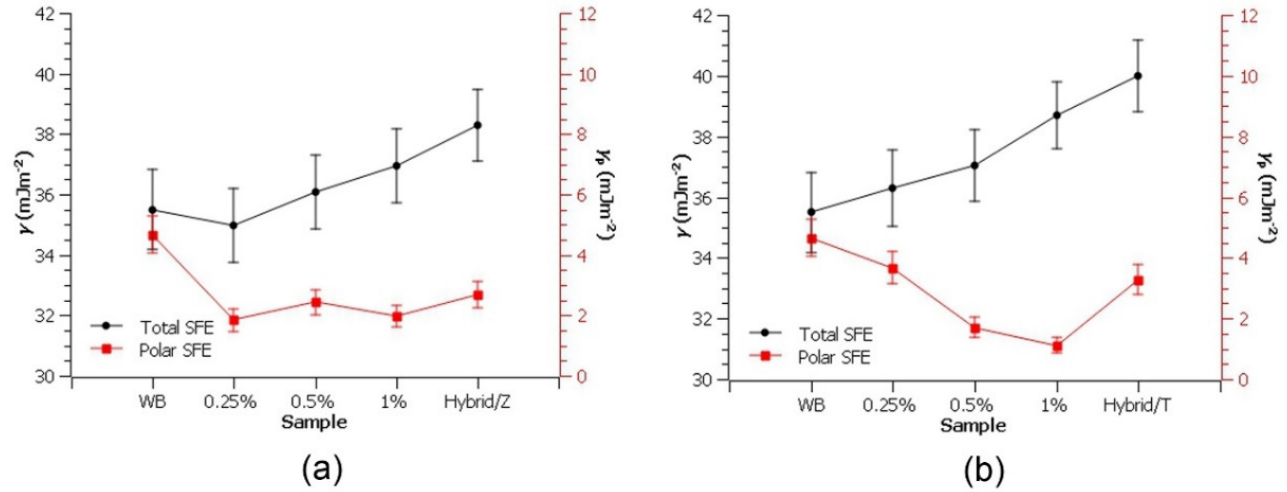
Figure 4. SFE of investigated samples coated with nanocomposite including ( a ) ZnO and ( b ) TiO 2 .